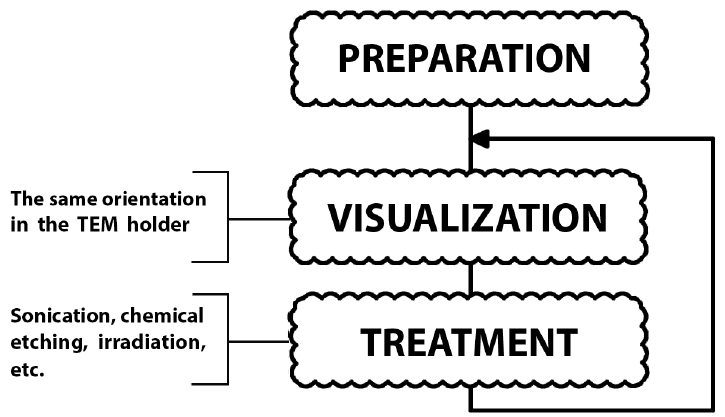
Figure 1. Procedure chart illustrating an approach used to examine the adhesion strength of CNF on the surface of microfibers.